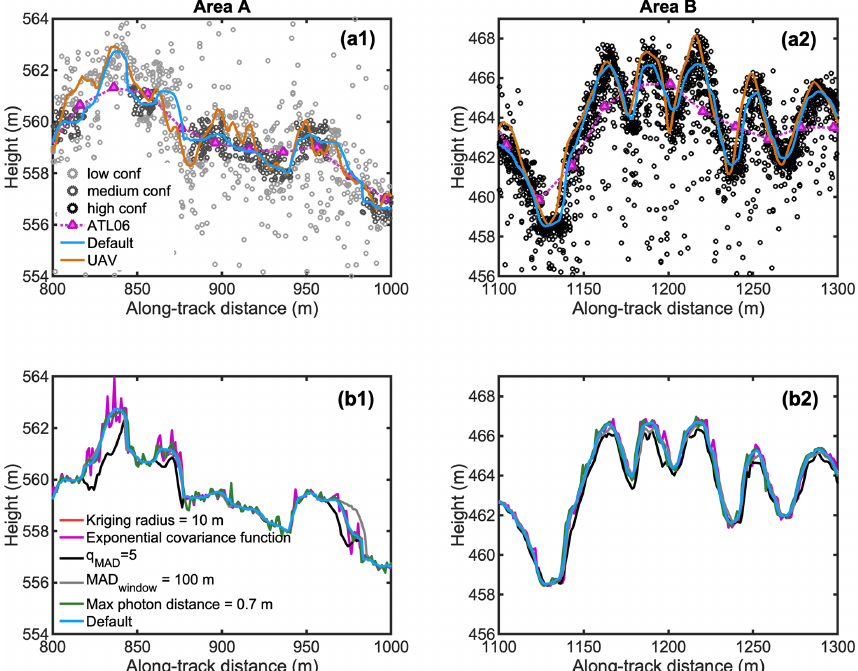
Figure B2. Elevation profiles in a 200m portion of area A (a1, b1) and area B (a2, b2) . The top panels contain the ATL03 data sorted in confidence levels (dots), the ATL06 data (pink triangles), the profiles measured by UAV photogrammetry (orange line), and the 1m interpolated ATL03 data using the default settings used in the main text (blue line). The bottom panels contain the 1m interpolated AT03 data using different origins and photon filtering